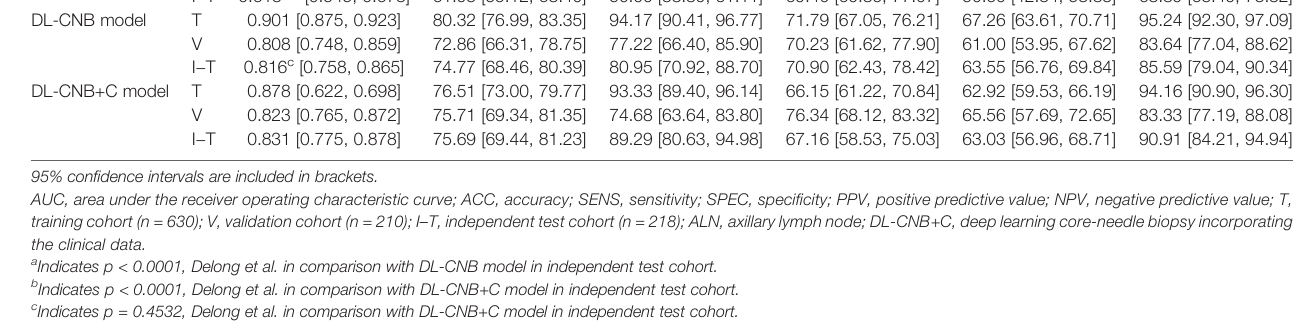
TABLE 2 | The performance in prediction of ALN status (N0 vs. N(+)).